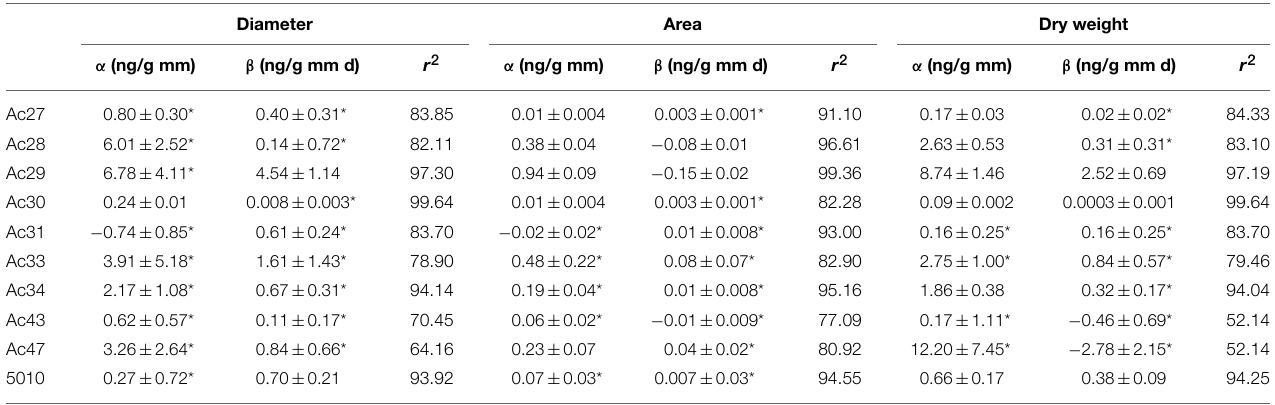
TABLE 5 | Parameters and standard errors concerning OTA estimated by the Leudeking-Piret model. Diameter Area Dry